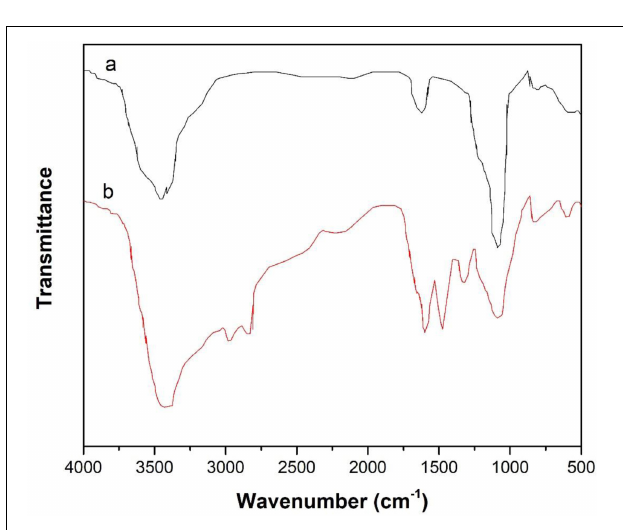
FIGURE 3 | FTIR spectrum of pristine MMO before and after PEI loading: (a) pristine MMO and (b) MMO-PEI-60. confirmed by these bands obtained in the FT-IR analysis. Ce-O stretching vibration is verified by bands at 848 and 521 cm − 1 .